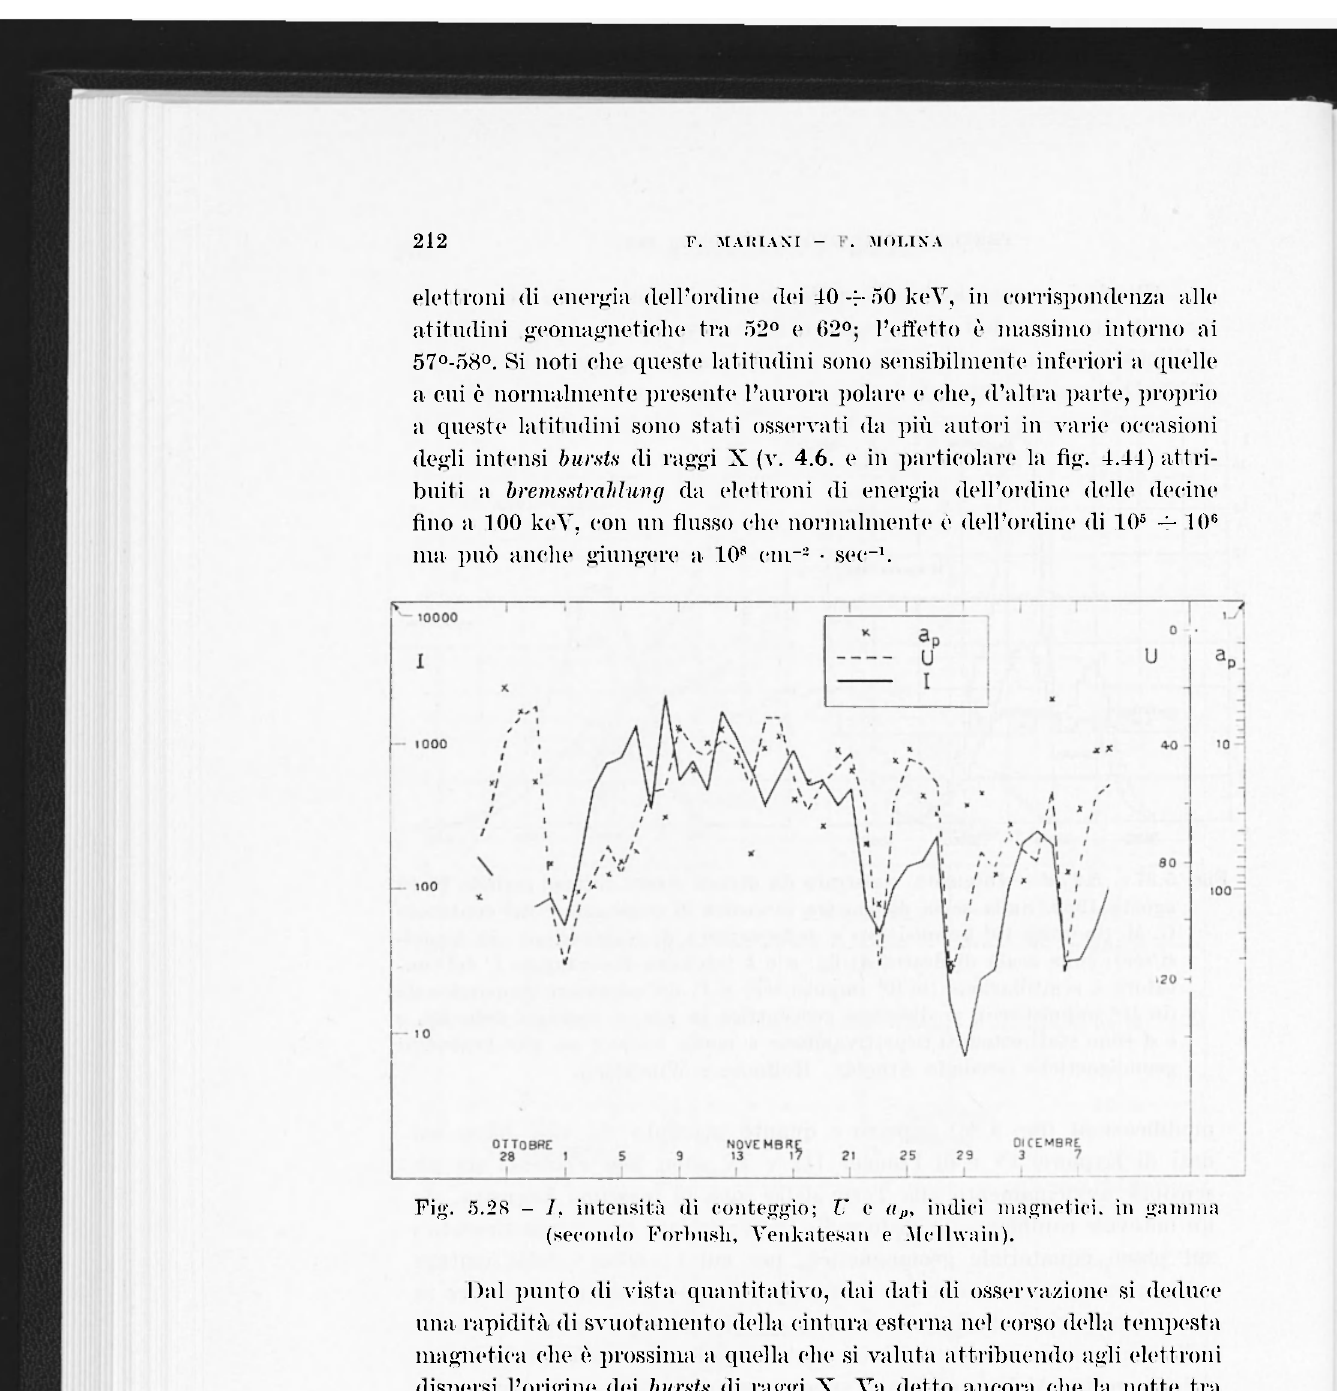
Fig. 5.28 - /, intensità di conteggio; U e u p , indici magnetici, in gamma (secondo Forbush, Venkatesan e